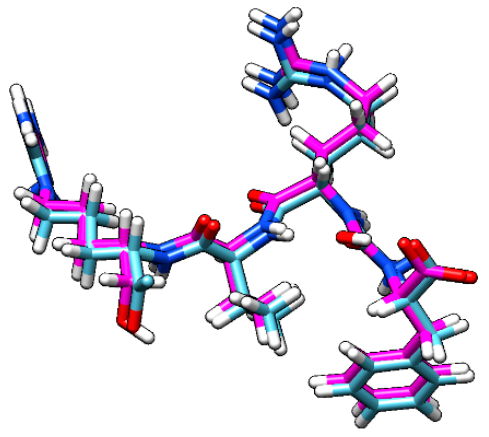
Figure 3. Docked antipain superposed with antipain from crystallography. In magenta, docked antipain; in blue, crystallographic antipain.